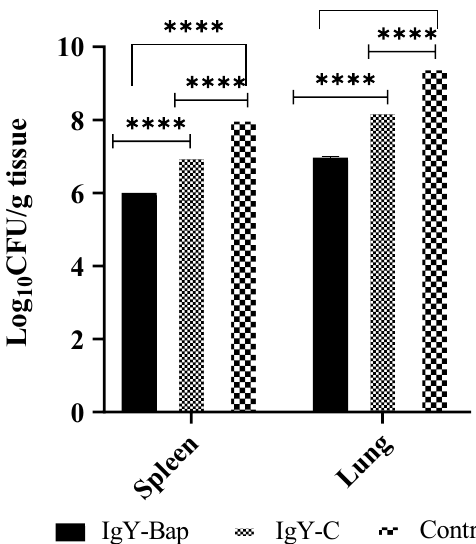
Figure 7. Bacterial load per gram spleen or lung tissue 16 h after challenge. The bacterial load was 2 log 10 CFU/g less than the control group, and 1 log 10 CFU/g less than the IgY-C group after 16 h. A significant difference ( p < 0.0001) was observed between the IgY-Bap group and control bacteria group as well as the IgY-C group 16 h after the challenge. Such difference was also observed between the IgY-C group and the bacteria group ( p < 0.0001). Control: The group without any treatment before infection. IgY-C: the group receiving control IgY antibody 1 h before inoculation with live bacterial suspension. IgY-Bap: the group receiving IgY-Bap